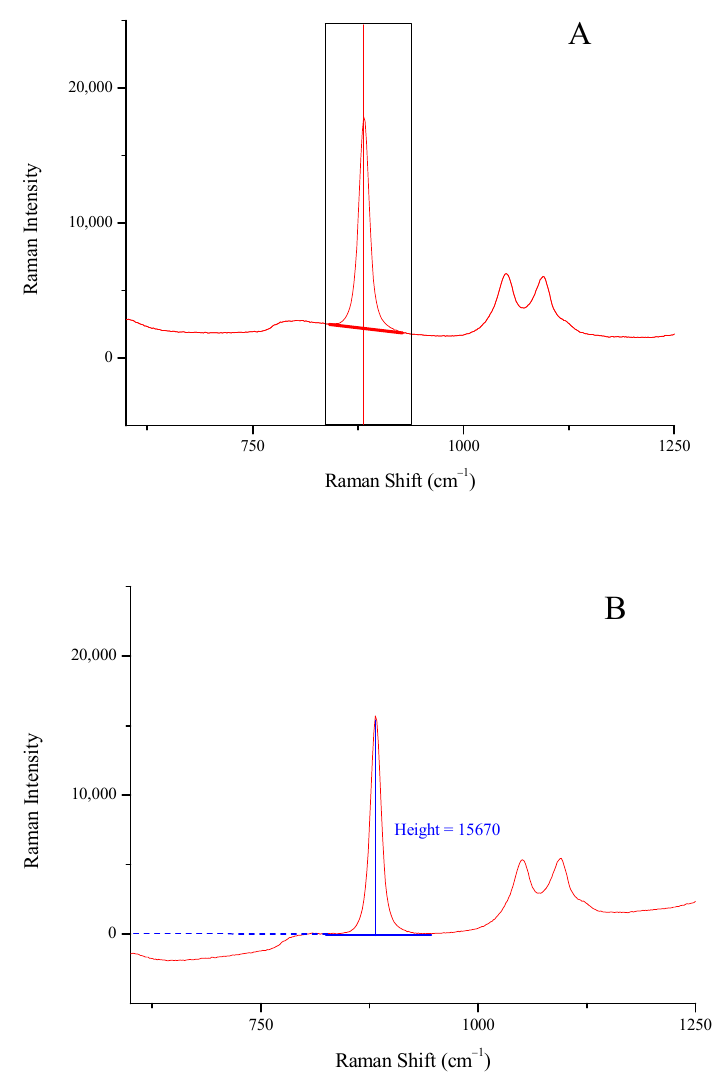
Figure 1. Drawing a two-point baseline ( A ), and background removal and height measuring ( B ) for the peak of ethanol at 878 cm −1 .